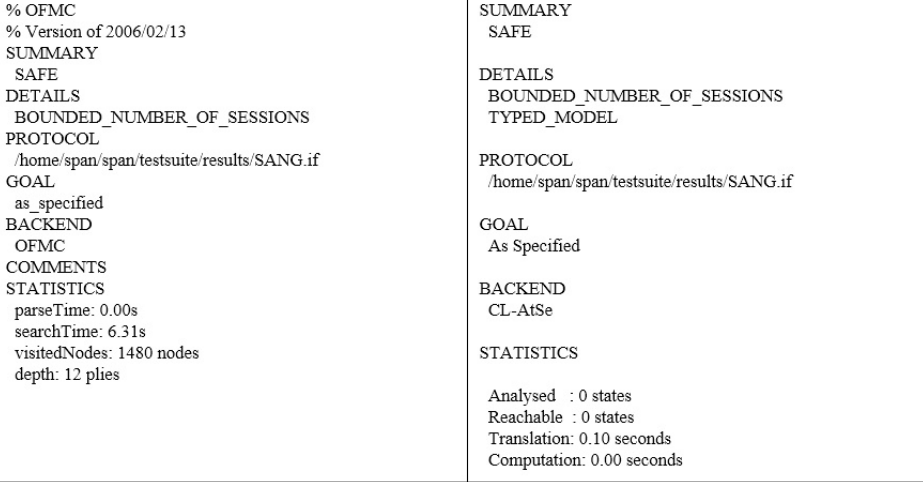
Figure 11. The AVISPA simulation result of the proposed